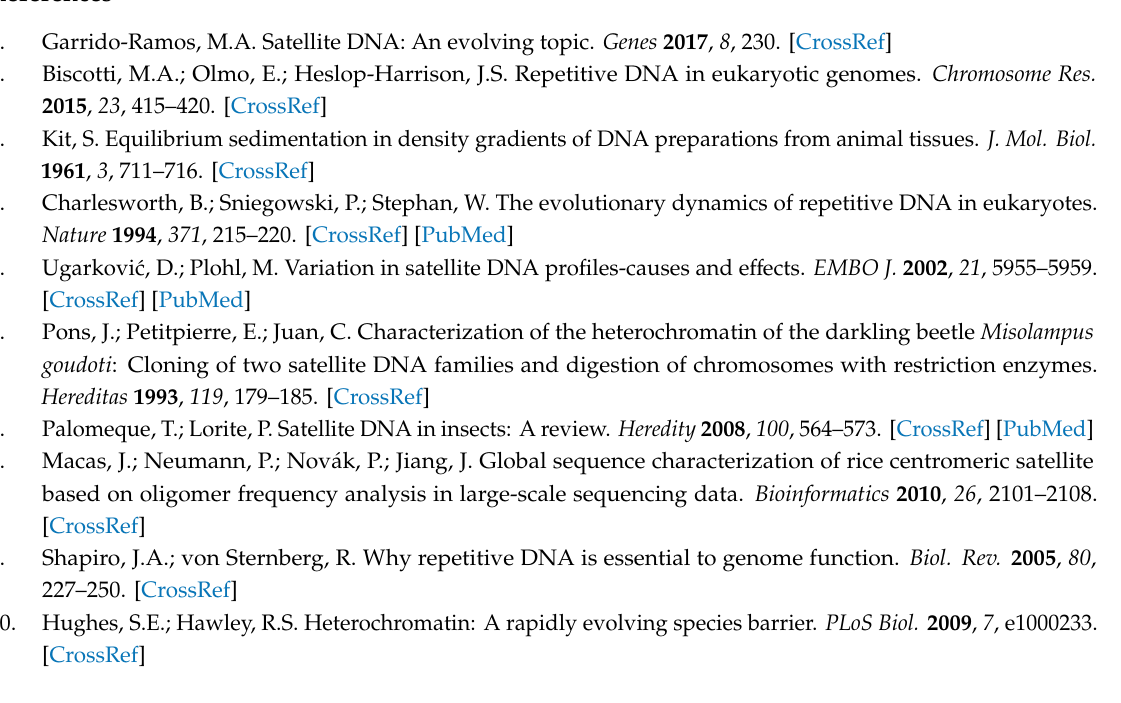
Figure S1: Separate repeat landscape of each satDNA family in Hippodamia variegata satellitome; Figure S2: (A) Dotplot of an internal region of one of the sca ff old of Harmonia axyridis with the presence of a tandem array of repeat sequences with similarity with the HvarSat16-87 satDNA family of Hippodamia variegata. (B) Alignment and consensus sequence of repeat sequences found in two sca ff olds of Harmonia axyridis (accession number AP018897 and AP018898). (C) Alignment of HvarSat16-87 and the consensus sequence of the repeat sequences found in Harmonia axyridis; Figure S3: (A) Repeat landscape of the Hvar-Sat01-277 satellite DNA showing the existence of two types of repeats. (B) Alignment of the consensus sequence of the Hvar-Sat01-277 with the most abundant repeats (type I) and with the less abundant (type II); Table S1: Consensus sequence and accession numbers of the satDNA families found in Hippodamia variegata